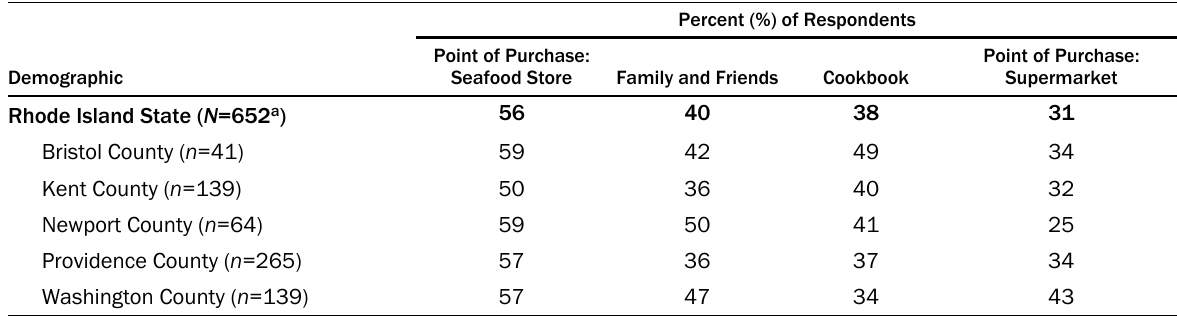
Table 4. Top Choices for Places to Get Information about Seafood, for the State of Rhode Island and by the Respondents’ County of Primary